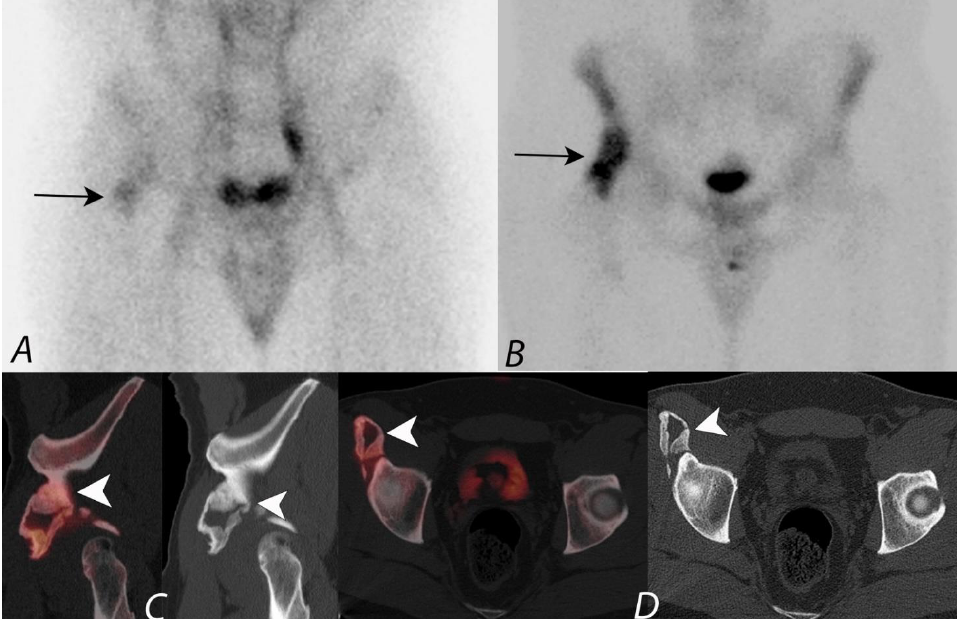
Figure 16. Patient presenting with right hip and with clinical history of possible heterotopic ossification. Planar blood pool image ( A ) and delayed image ( B ) in anterior projection from a 99m Tc MDP bone scan demonstrating increased blood pool activity and delayed focal uptake localizing to the right hip region (long black arrows). Fused sagittal image with correlative CT image ( C ) and fused coronal with correlative CT image ( D ) localizes the focal activity to an area of exuberant heterotopic ossification along the anterior aspect of the anterior wall of right acetabulum. Given increased blood pool activity, the heterotopic ossification is immature and represents an ongoing process.